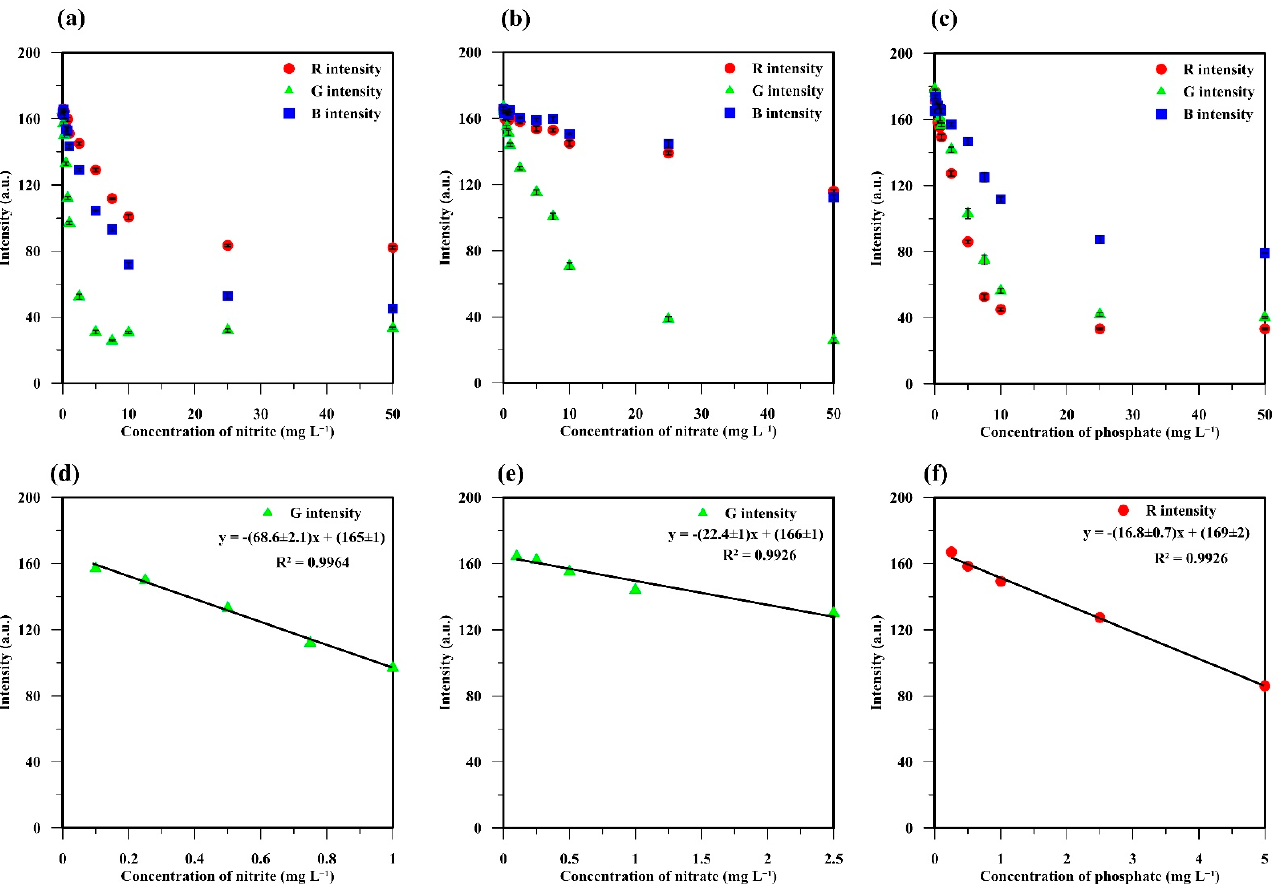
Figure 5. Relationships between the RGB intensities and concentrations of ( a ) nitrite, ( b ) nitrate, and ( c ) phosphate and their linear relationships, which can be used for quantitative analysis of ( d ) nitrite, ( e ) nitrate, and ( f ) phosphate. Table 1. Nutrient analysis performance of nutrient test kits and on-mobile DIC.